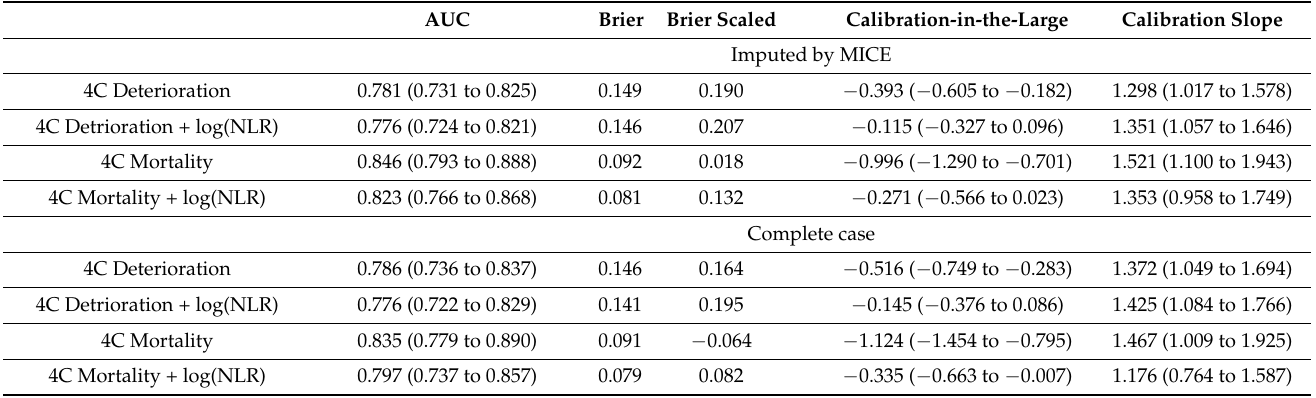
Table 2. Model performance before and after model updating in SARS-CoV-2 patients admitted to Triemli Hospital. AUC